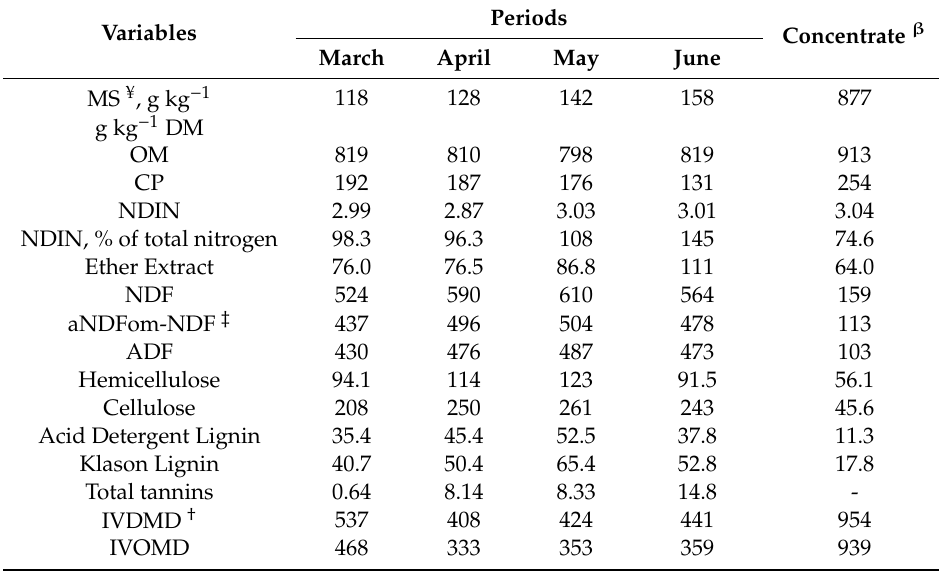
Table 4. Composition of ruminal extrusa samples † collected from sheep on Caatinga -native pasture during the rainy